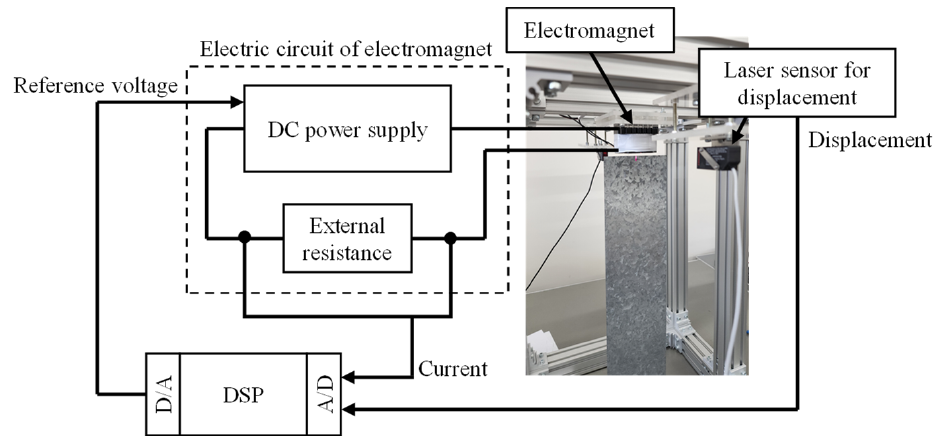
Figure 3. Schematic of this magnetic levitation system.